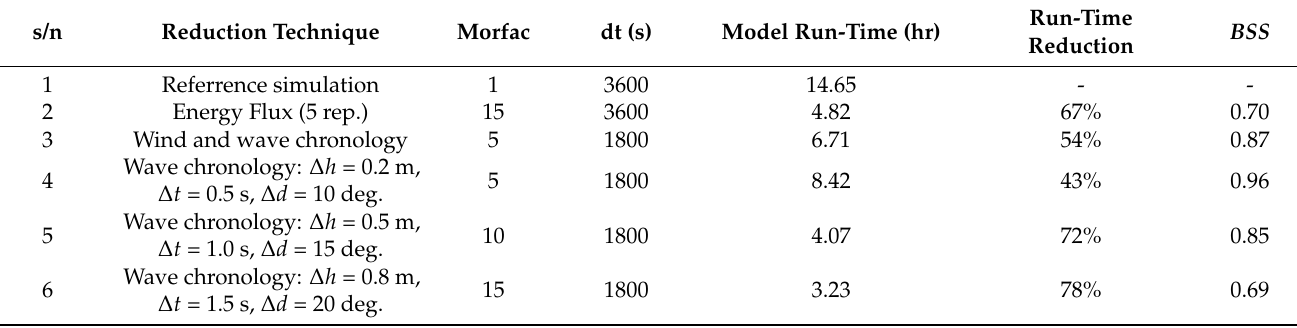
Table 2. Performance assessment of the wave input reduction